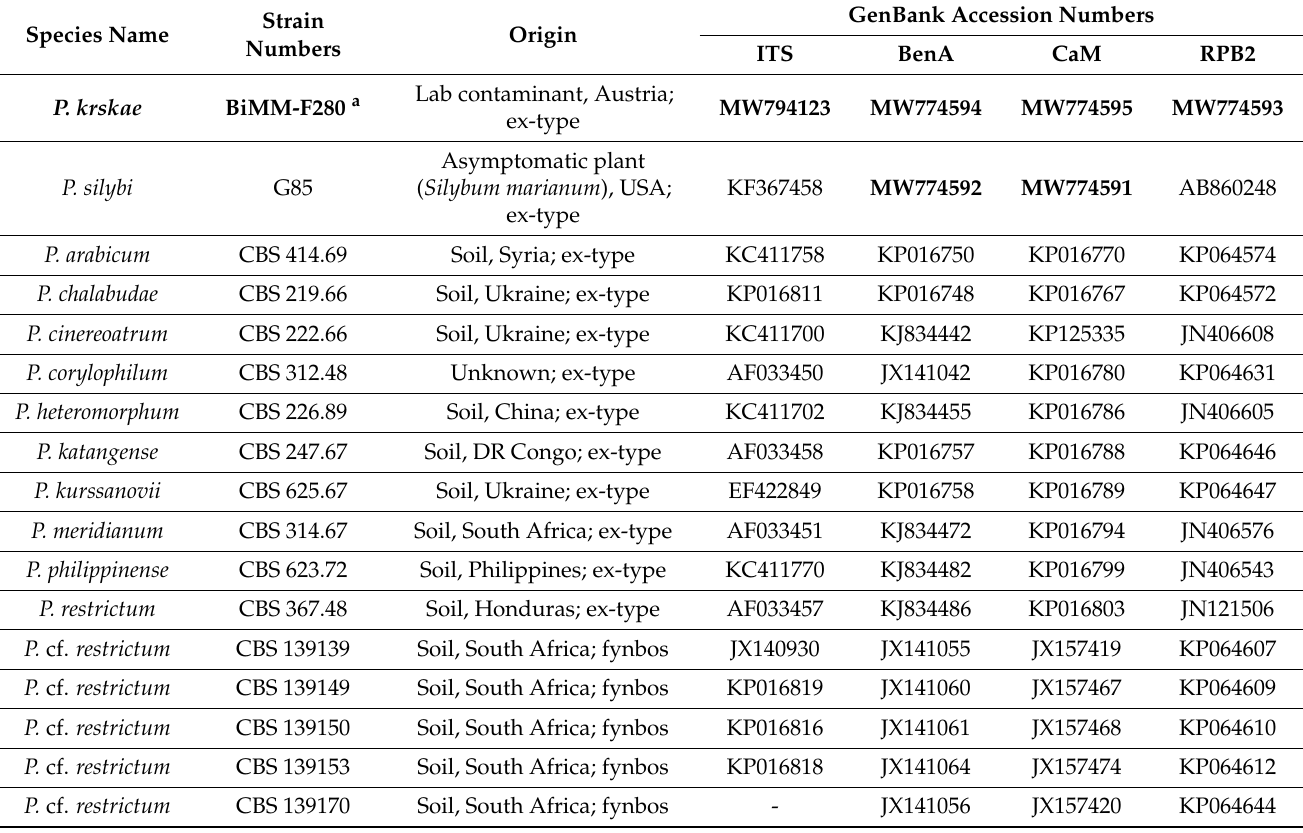
Table 1. List of fungal